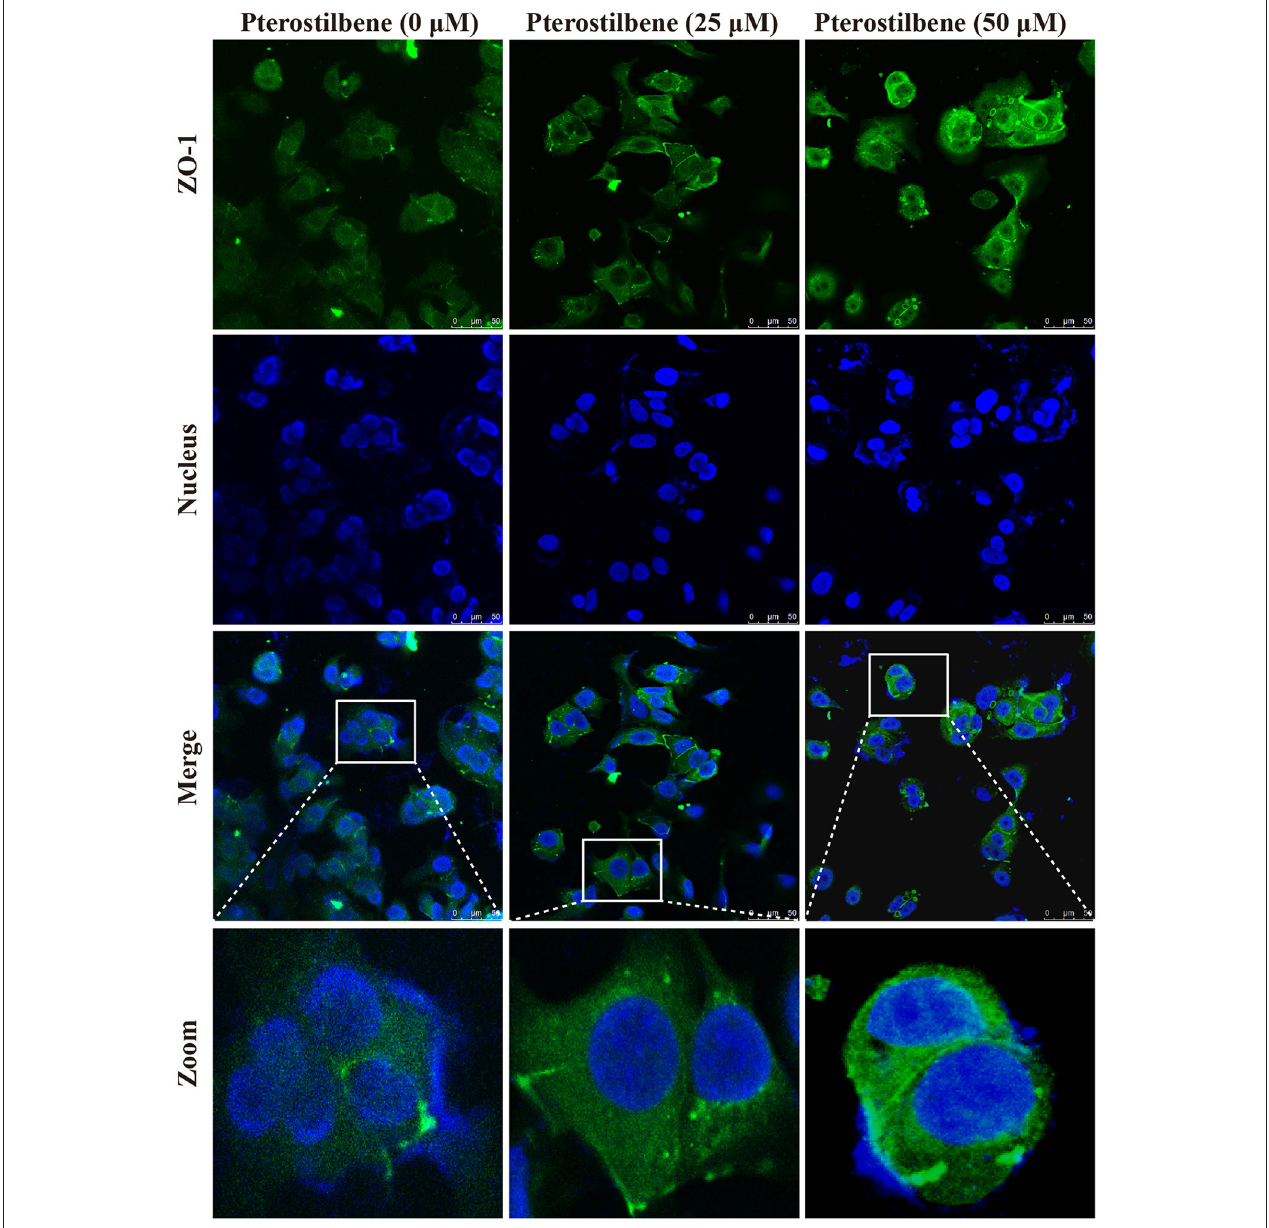
FIGURE 8 | Immunofluorescent staining of ZO-1 expression. Cells were treated with pterostilbene at different concentrations for 24h, images captured using confocal fluorescence microscopy.